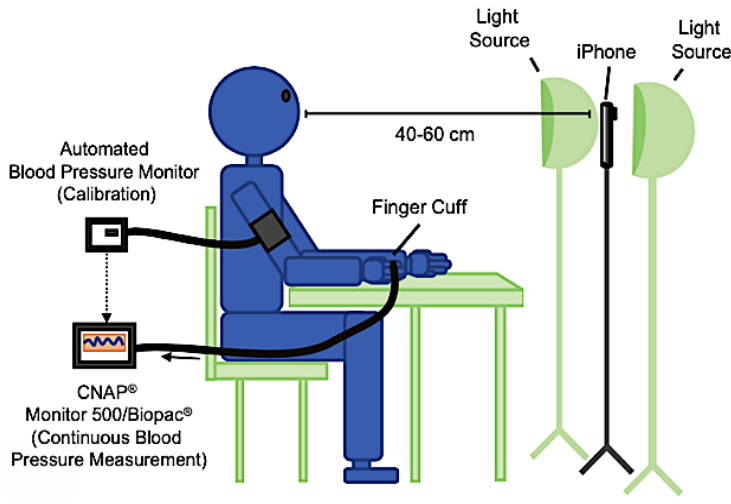
Figure 2. Data collection setup used in [29].